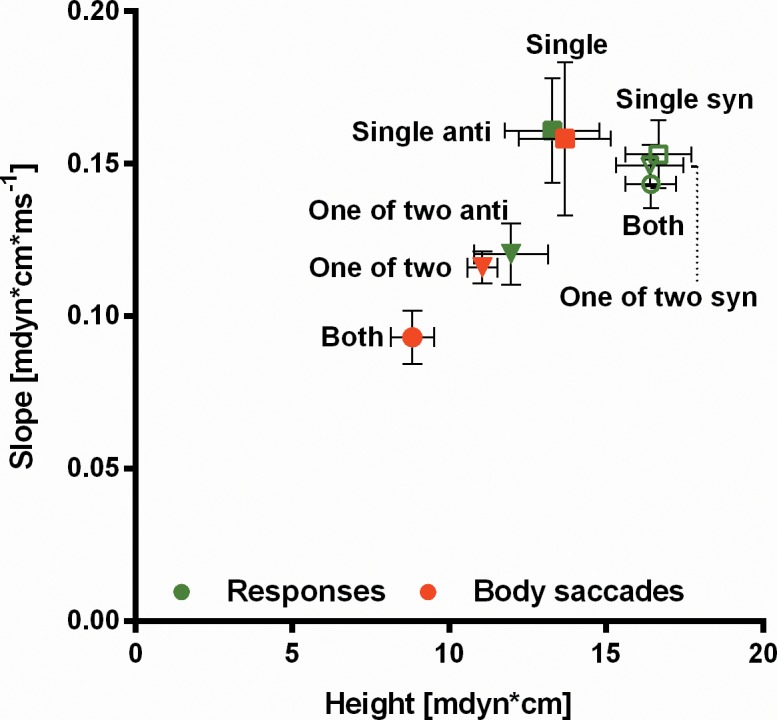
Slope of the rising phase and height of the torque responses (green) and spontaneous body saccades during ITIs (red).For the experimental conditions ‘Single’ (N = 21) and ‘One of two’ (N = 20) data are split into ‘syn’ and ‘anti’ with regard to the response polarity. For the experimental condition 'Both' no such differentiation can be made. Syn-directional responses have a similar shape as the ones generated when both stripes are displaced ('Both'; N = 21). Body saccades differ in slope and height in the three experimental conditions ('Single', 'One-of-two', 'Both'). Anti-directional responses resemble body saccades.